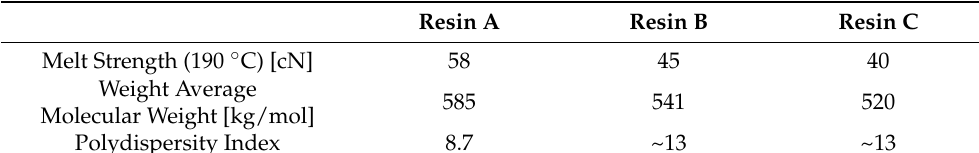
Table 1. Summary of material properties of the PP homopolymers used for foaming. Melt strength and molecular properties were measured based on the ExxonMobil test method.